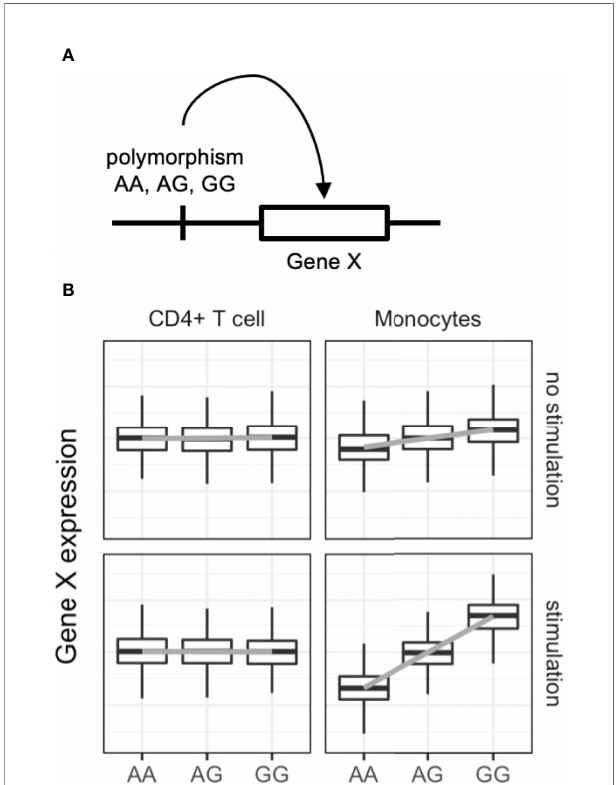
FIGURE 2 | Dynamic eQTL of the immune cells. (A) Schematic representation of expression quantitative trait locus (eQTL) analysis. eQTL is an association test between common single nucleotide polymorphisms and nearby (in most cases) gene expression. (B) An example of dynamic eQTL in immune cells. eQTL effect sizes, expressed as standardized linear regression coef fi cients, are cell-type and cell-state dependent. In this example stimulated monocytes have four times more eQTL effects compared with unstimulated